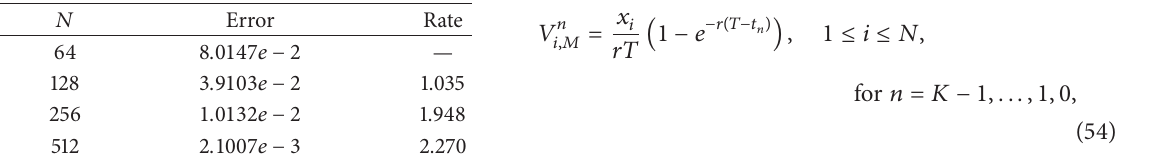
Table 2: Numerical results for Test 1.